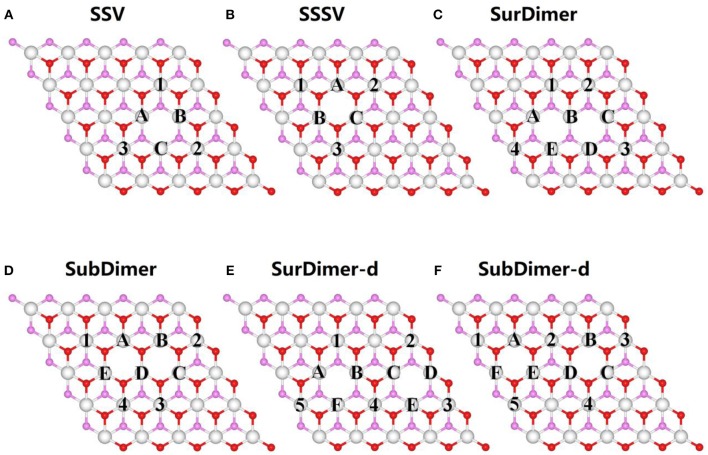
Structural model of the CeO2 (111) unit cell with 5 × 5 periodicity. (A) single surface vacancy, SSV, (B) single subsurface vacancy, SSSV, (C) nearest neighbor surface oxygen vacancy dimer, SurDimer, (D) nearest neighbor subsurface oxygen vacancy dimer, SubDimer, and (E) third-nearest neighbor surface oxygen vacancy pair, SurDimer-d. (F) third-nearest neighbor surface oxygen vacancy pair, SubDimer-d. Ce cations in the outermost trilayer are shown as white balls. Surface and subsurface oxygen atoms are shown as red and pink balls, respectively. The labeled cerium atoms denote possible Ce3+ locations on nearest-neighbor (A, B, C, D….) or next-nearest-neighbor (1, 2, 3, 4….) sites to the vacancies. Only the three outermost atomic layers are shown for simplicity.